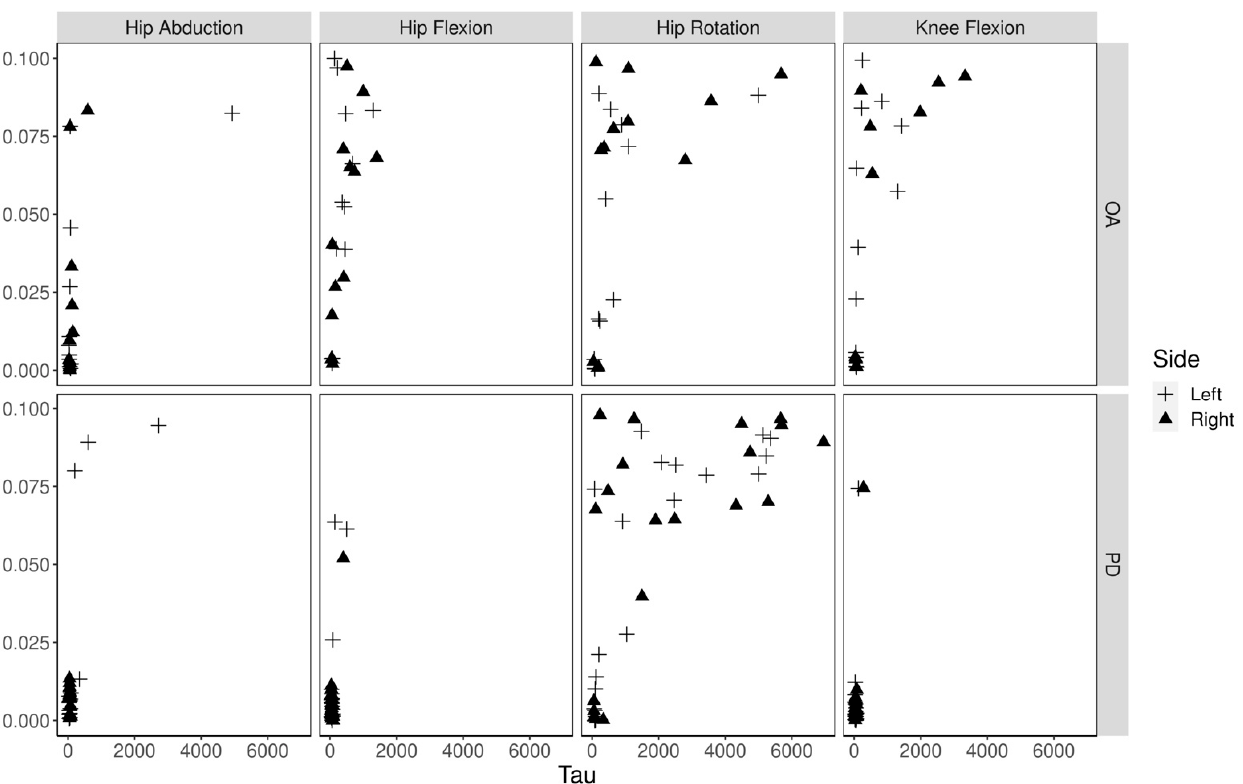
Figure 3. Tau values at each limb measure. An unconventional ACF plot showing the ACF values closest to 0 at the lowest possible tau (lag). Each recording’s observed tau values were used to calculate the respective ApEn. While there was no statistical significance in overall left vs. right and overall PD vs. OA tau values, the values for knee flexion in OA has a much wider range than in PD. The ApEn of knee flexion was also found to be significantly lower in left knee flexion than right knee flexion in PD (t(12.5) = 0.63, p = 0.02), however in OA there was no difference (t(7.0) = 0.10, p = 0.93).